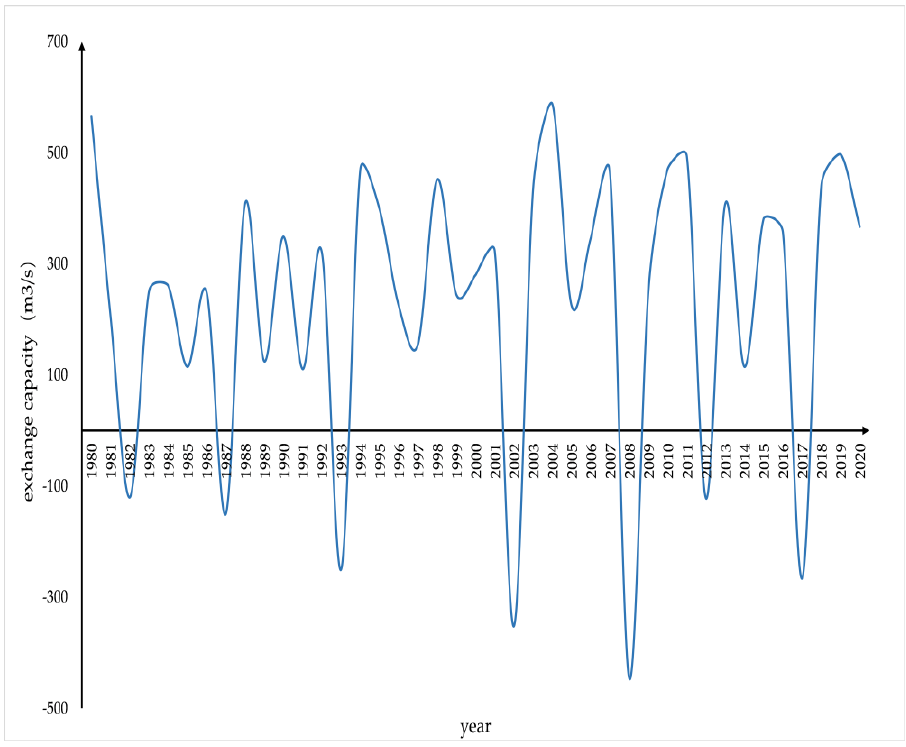
Figure 8. Change in exchange volume in Jinan section from 1980 to 2020.